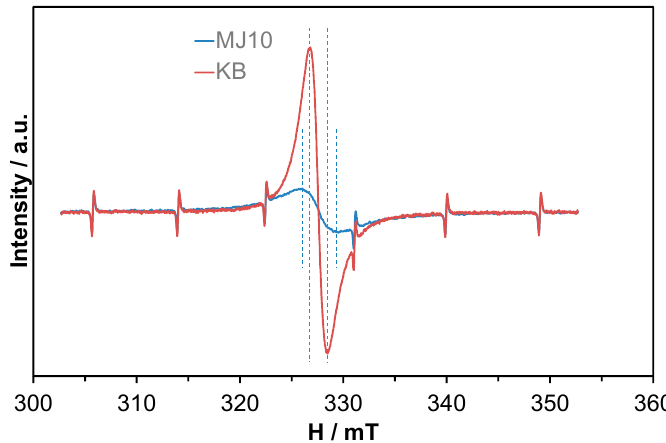
Figure 4. ESR signals of KB and MJ10 at room temperature under vacuum.